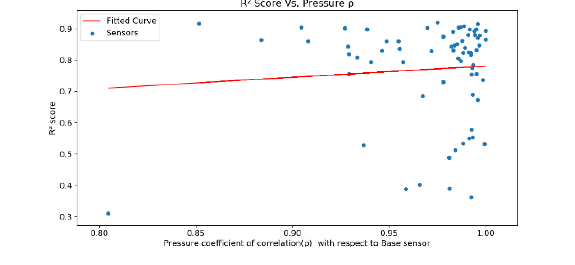
Figure 14. Pressure Correlation and R 2 Score